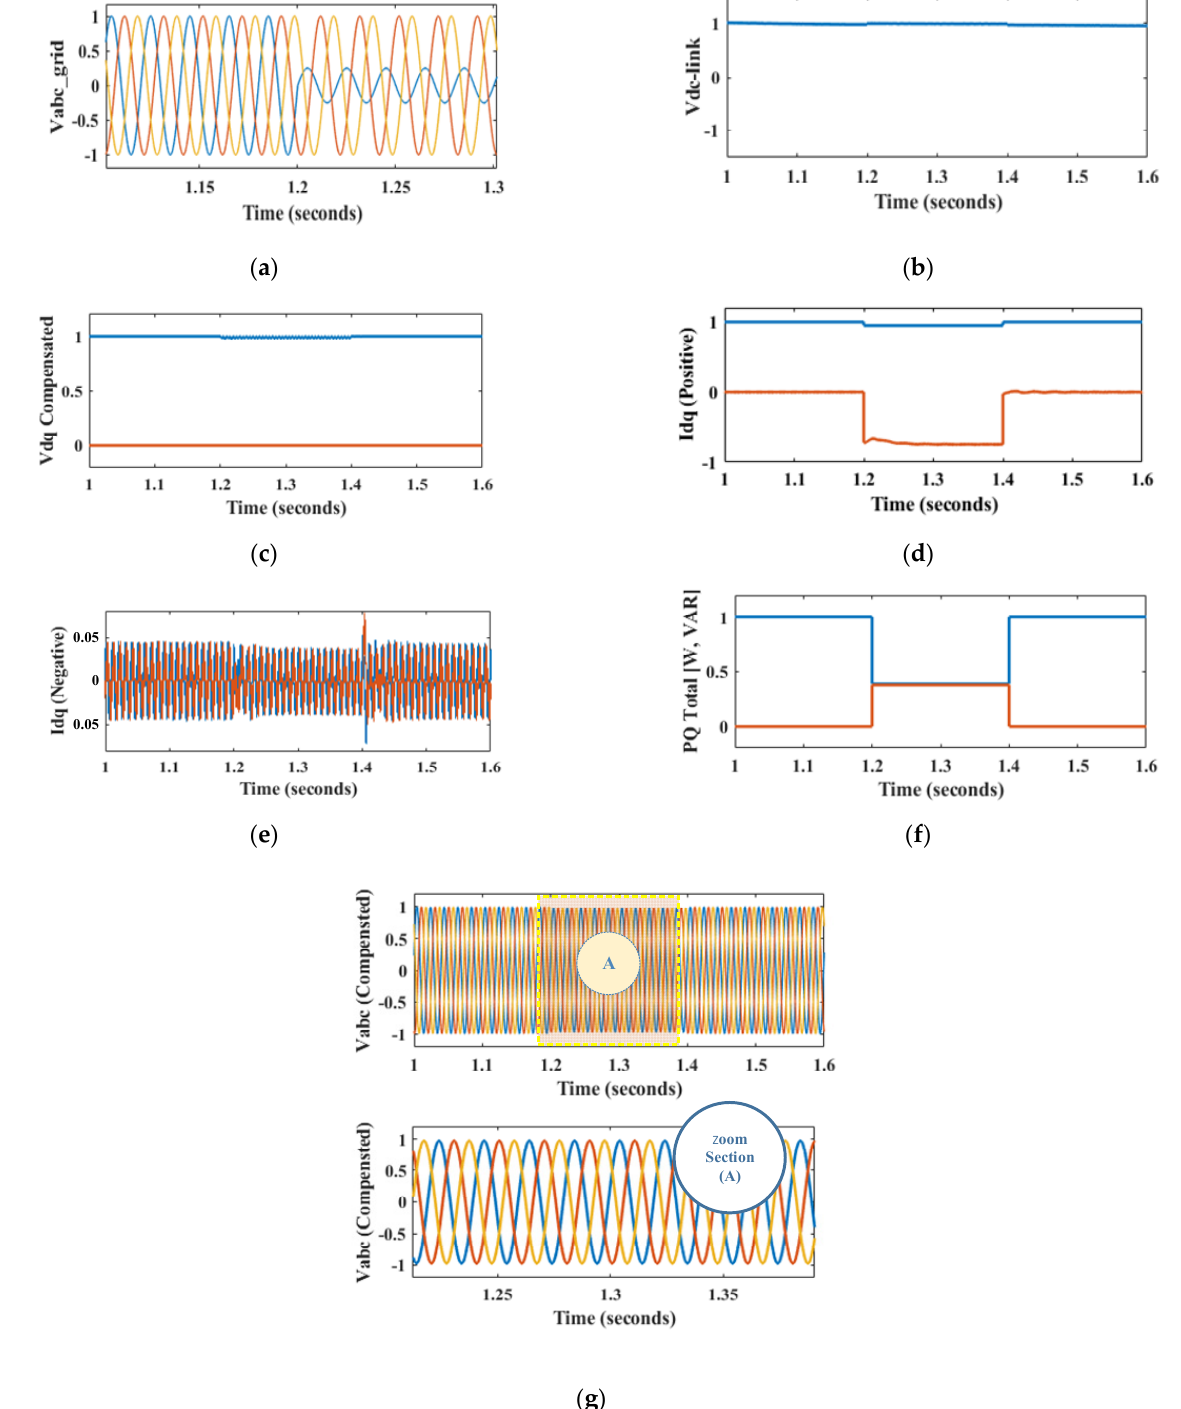
Figure 10. Simulated results of the proposed technique: ( a ) asymmetric grid voltage, ( b ) regulated DC-link voltage, ( c ) positive sequence voltages, ( d ) positive sequence currents, ( e ) negative sequence currents, ( f ) active and reactive powers during fault compensation, and ( g ) compensated three phase grid voltages.